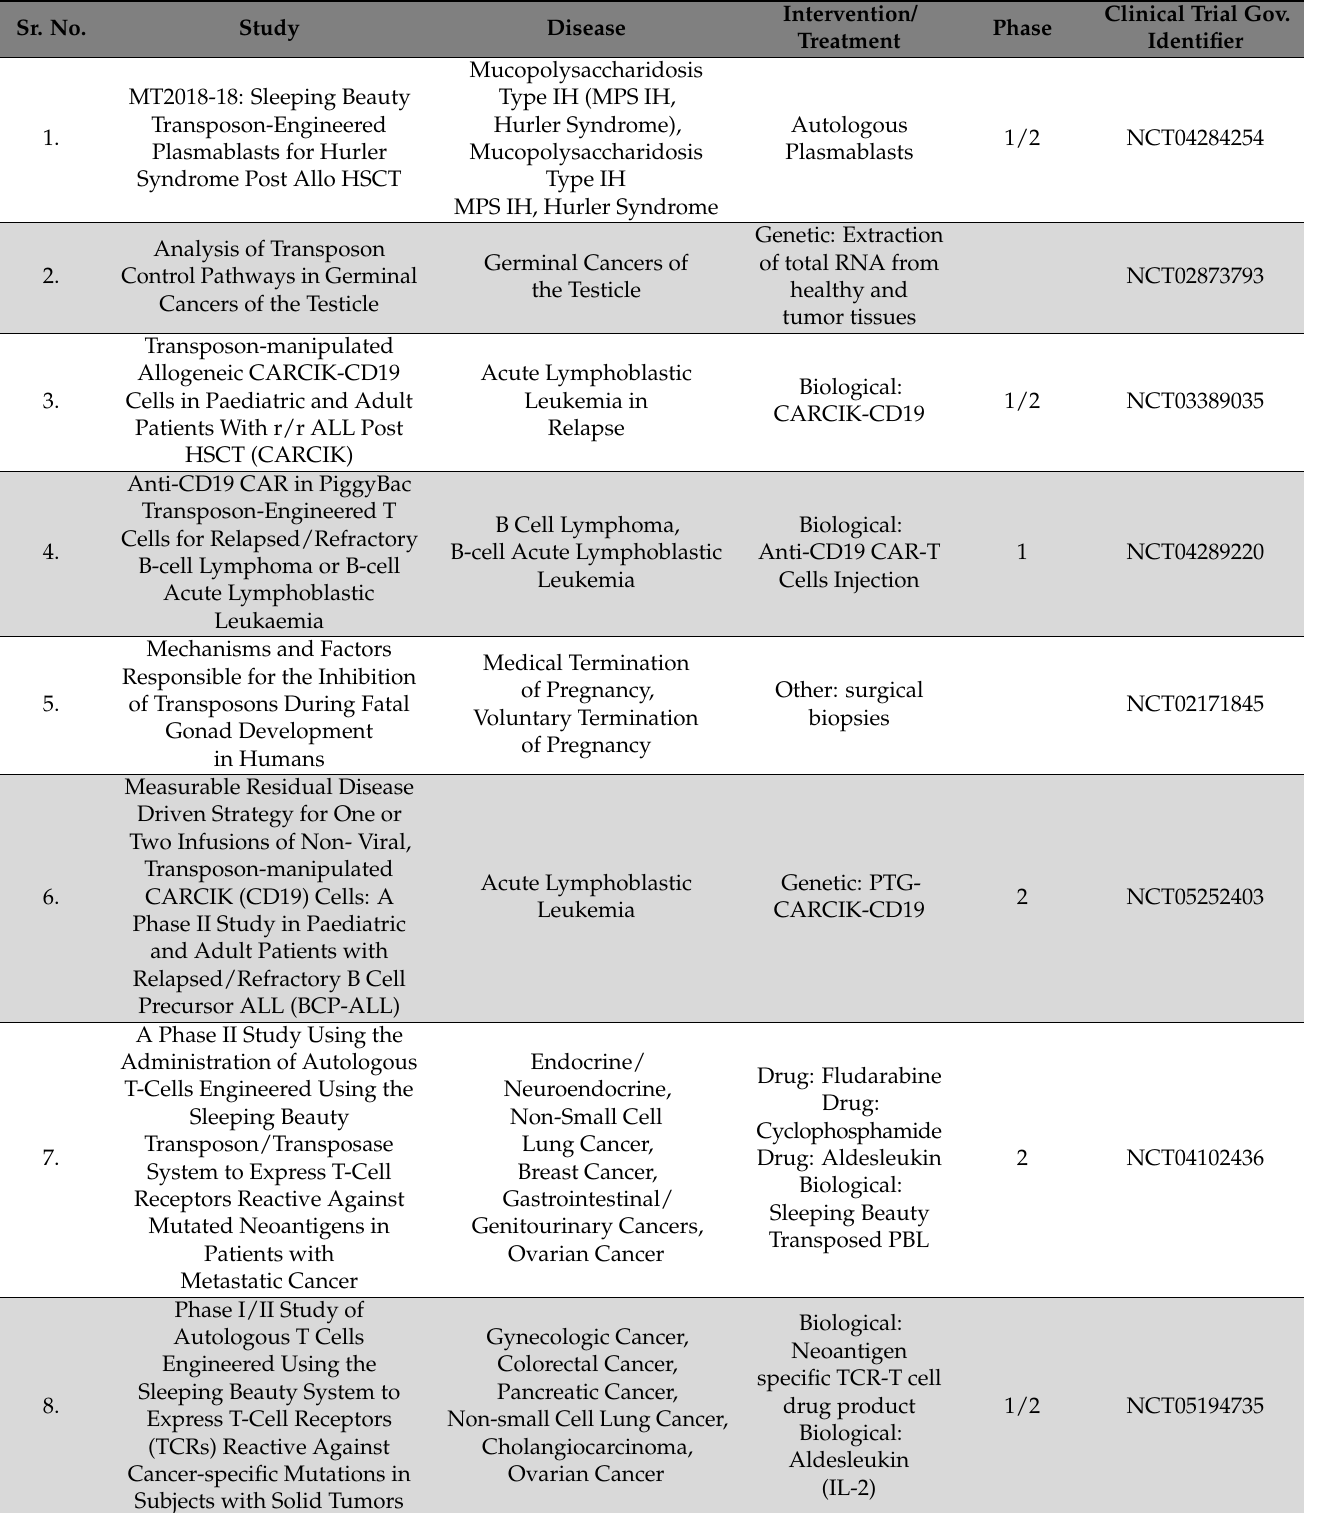
Table 3. Clinical advances in transposon-based gene